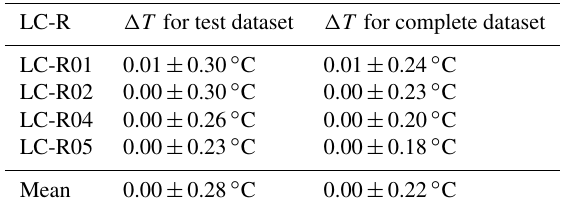
Table D1. Comparison of the obtained T difference ( (cid:49)T = T LC-R − T AWS ) when using the test LC-R dataset and the complete LC-R